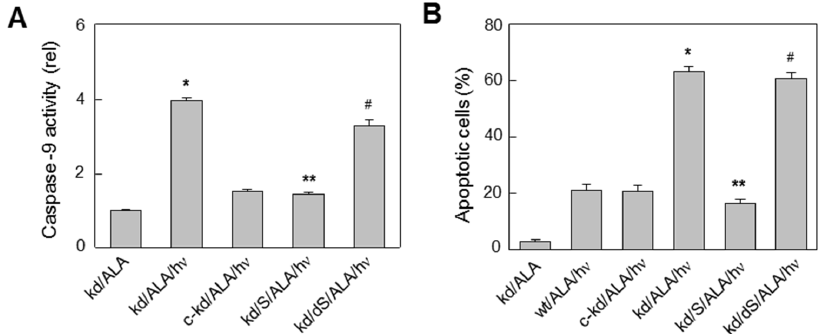
Figure 3. Effect of iNOS knockdown on extent of caspase-9 activation and apoptosis of ALA/light-challenged COH-BR1 cells. Wild-type (wt), shRNA-induced knockdown (kd), and control knockdown (c-kd) cells were pre-incubated with 1 mM ALA (45 min) and irradiated (1 J/cm 2 ) in the absence vs. presence of 0.1 mM SPNO (S) or decomposed SPNO (dS), added 10 min before irradiation: ( A ) Caspase-9 activity at 2 h post-hν; and ( B ) Hoechst-assessed apoptosis at 20 h post-hν. Plotted values: means ± SD (n = 3); * p < 0.001 compared with c-kd/ALA/hν; ** p < 0.001 compared with kd/ALA/hν; # p < 0.01 compared with kd/S/ALA/hν. (Reproduced from Reference [51], with permission).